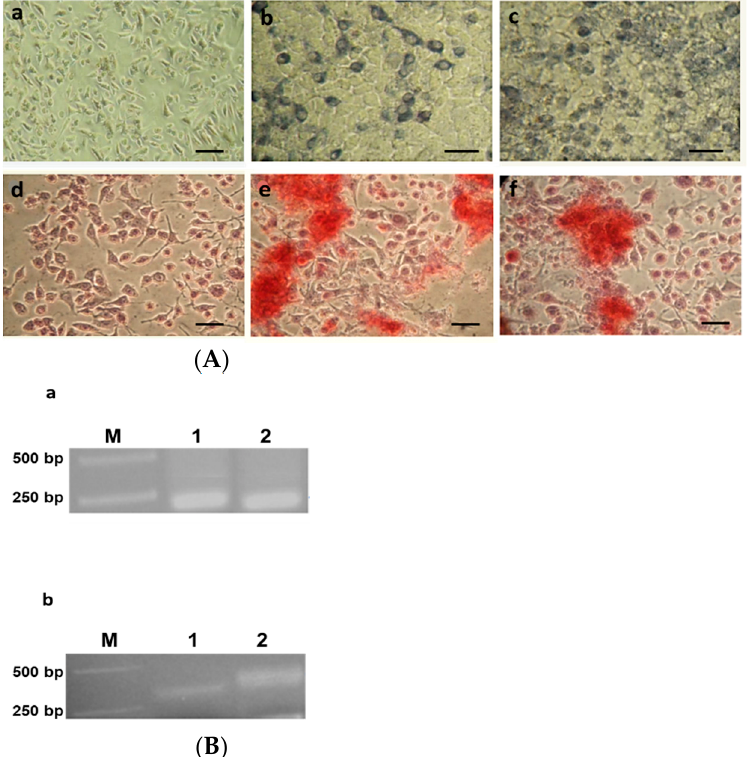
Figure 2. ( A ) . ( a – c ) Detection of alkaline phosphatase activity in ( a ) control cells MRC-5 (treated with DMSO < 1%) and ( b , c ) MRC-5 cells treated with 100 nM of aza-reversine 2. The differentiated cells are stained blue-purple and are more circular in shape, while control cells maintain their original morphology and are not stained positive for alkaline phosphatase. ( d – f ) Detection of extracellular calcium deposits after alizarin red staining of ( d ) control cells (treated with DMSO < 1%) and ( e , f ) cells that were treated with 100 nM of aza-reversine 2. The calcium deposits are stained orange-red and indicate successful differentiation of the cells around them, while control cells remain colorless. Images ( a – f ) are taken using optical microscopy with 40 × magnification. Scale bars: 0.5 µ m. ( B ) Gel electrophoresis of rt-PCR products after amplification of ( a ) Gus-b. The template used was mRNA isolated from control cells (lane 1) and cells treated with aza-reversine 2 (lane 2). ( b ) Osteocalcin. The template used was mRNA isolated from control cells (lane 1) and cells treated with 2 (lane 2).